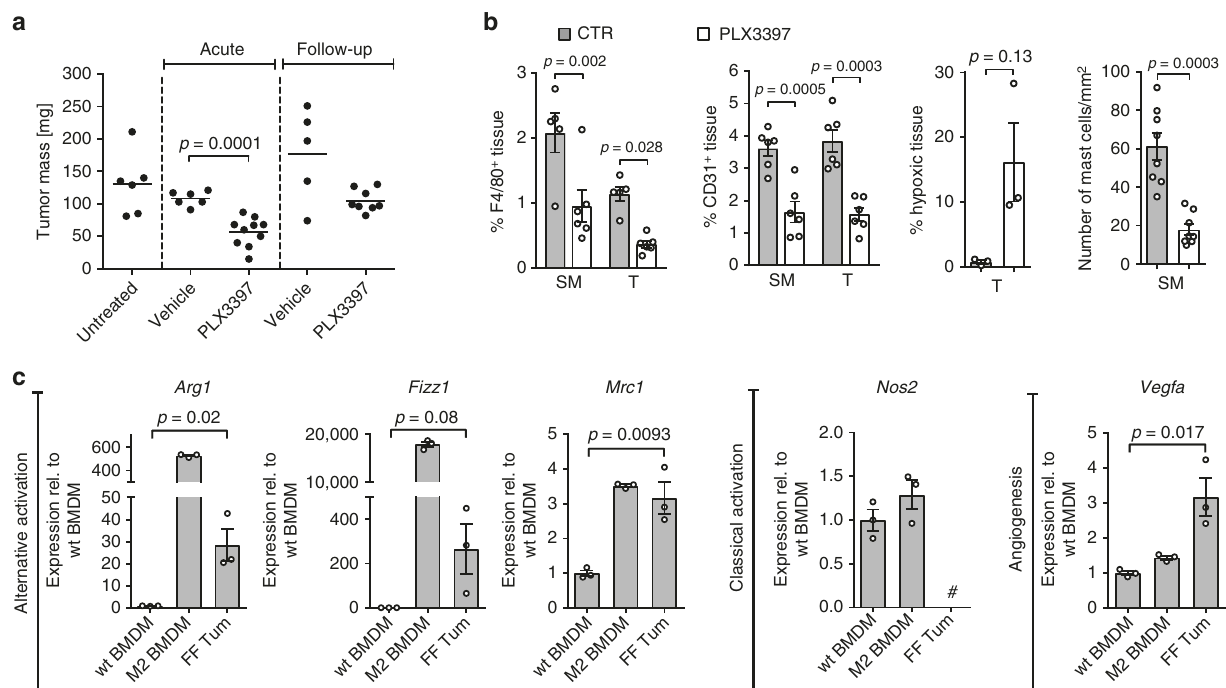
Fig. 5 Pharmacological macrophage targeting and macrophage polarization in gp130 FF tumors. a Total tumor burden in gp130 FF mice was quanti fi ed either acutely after a 4-week-treatment period with PLX3397 (Csf1r/c-Kit/Flt3 tyrosine kinase receptor inhibitor) or vehicle or after a 4 weeks treatment-free follow-up period. Each symbol represents an individual mouse. Data from three independent experiments are presented. t -test t (df) = 5.23 (14). b Quanti fi cation of F4/80, CD31, Hypoxyprobe or toluidine-blue-stained sections of submucosa (SM) or gastric tumors (T) of gp130 FF mice of the indicated acute treatment cohort. F4/80: n = 5 (Vehicles) and n = 6 (PLX3397), one-way ANOVA F (DFn, Dfd) = 12.34 (3, 18); CD31: n = 6, one-way ANOVA F (DFn, Dfd) = 18.33 (3,20); hypoxic tissue: n = 3, t -test with Welch ’ s correction t (df) = 2.53 (2); mast cells: n = 8 (both groups), and t -test with Welch ’ s correction t (df) = 5.59 (9.27). c qPCR expression analysis of genes associated with alternative activation ( Arg1, Fizz1, Mrc1 ), classical activated ( Nos2 ) and angiogenesis ( Vegfa ) of puri fi ed F4/80 + tumor-associated macrophages (FF Tum) or following stimulation of bone marrow-derived macrophages (BMDM) from wild-type mice and stimulated either with vehicle (wt BMDM) or with IL-4/IL-13 (20 ng/ml) to induce an alternative activated